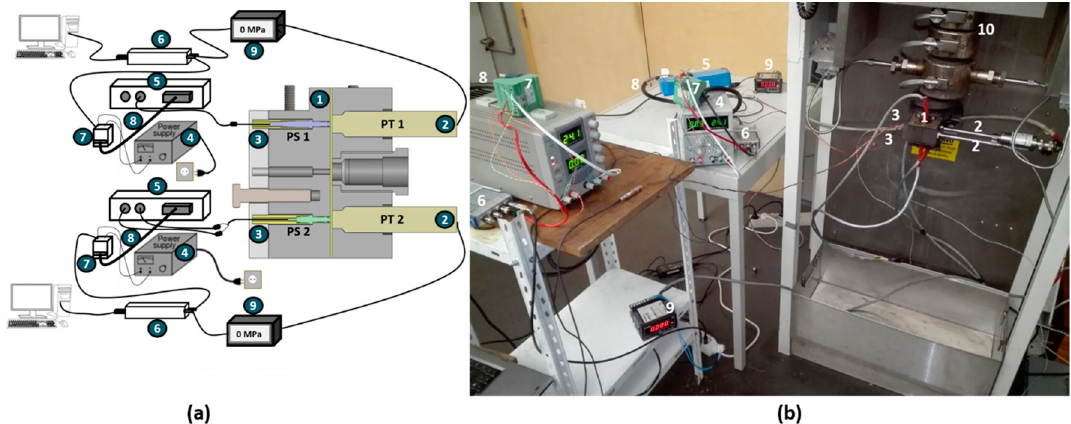
Figure 2. Schematic view ( a ) and photograph ( b ) of the experimental set-up. 1: double slit die. 2: conventional pressure transducers. 3: piezoelectric sensors. 4: power supply. 5: charge amplifier. 6: analog-to-digital converter (ADC) card. 7: terminal block for 25-Pin. 8:D-SUB Cable. 9: strain gage indicator. 10: capillary rheometer.